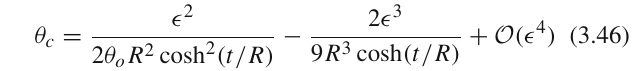
Fig. 4 We take (cid:9) = 1 / 1000, R = 100, θ o = 1 / 20 and G =